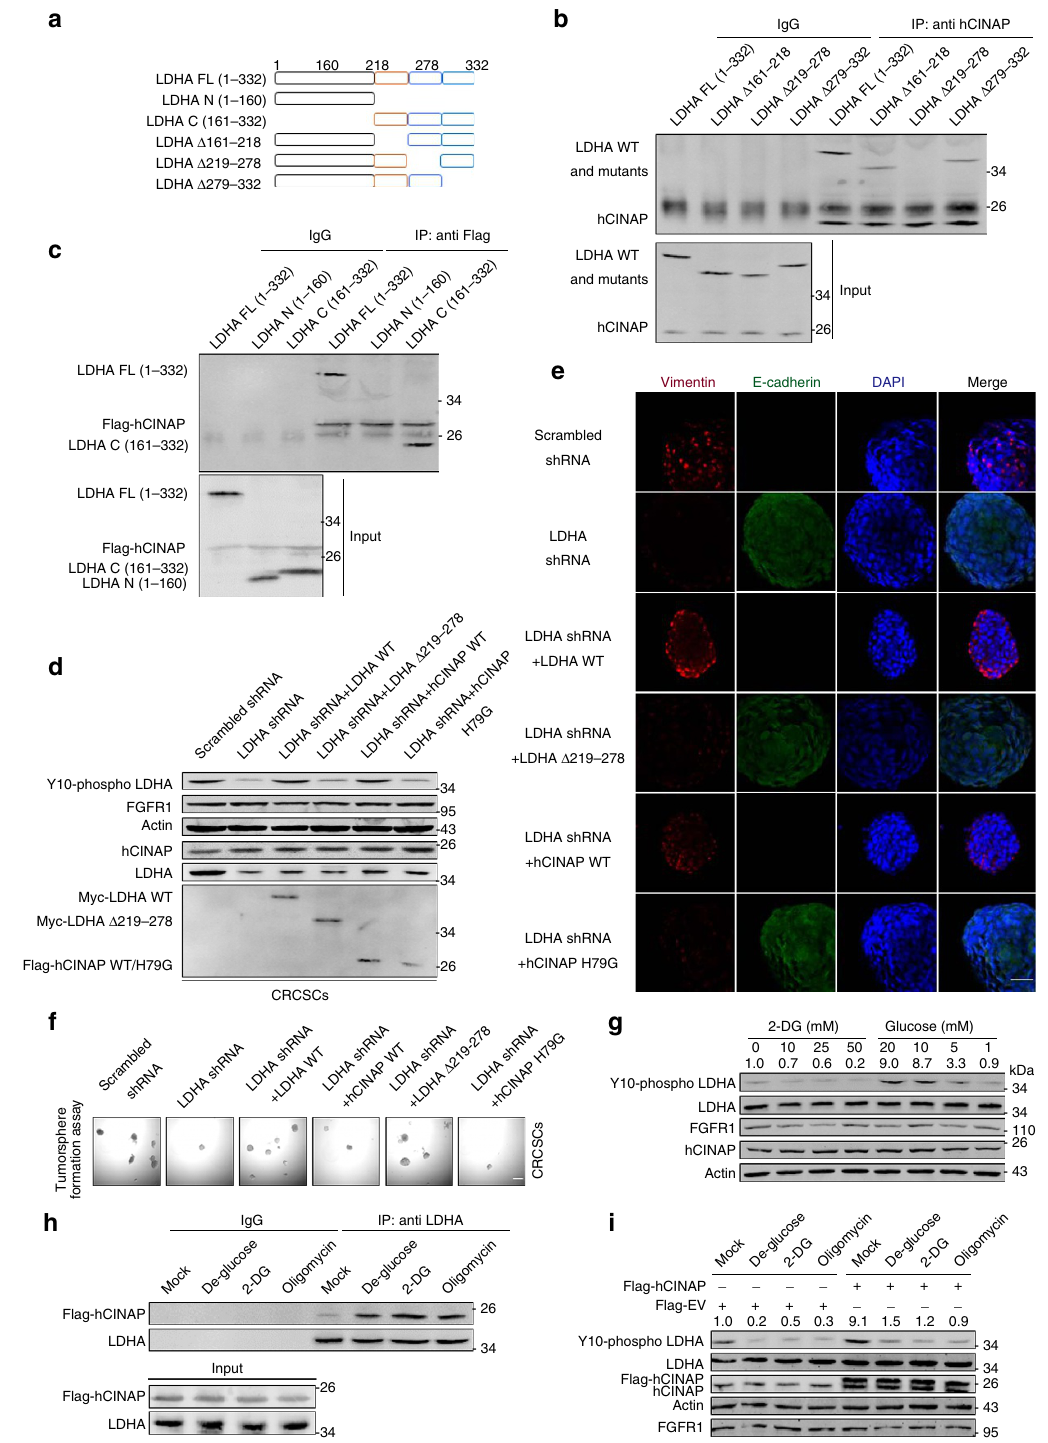
Figure 5 | The C-terminal domain of LDHA recruits hCINAP to facilitate LDHAY10 phosphorylation in a low-energy state. ( a ) Schematic diagram of the structural domain organization within LDHA. ( b , c ) Co-IP analyses of the interaction between various regions of LDHA and hCINAP in SW480 cells. IgG served as the negative control. ( d ) Western blot analysis of LDHA Y10 phosphorylation level in CRCSCs transfected with indicated plasmids. ( e ) Immunofluorescence analysis of the effect of shRNA-depleted LDHA and LDHA/hCINAP rescue expression on the mesenchymal–epithelial transition in CRCSCs labelled by Vimentin (red), E-cadherin (green). The nucleus was counterstained with DAPI (blue). Scale bar, 100 m m. ( f ) Tumorsphere formation assay using cells in e . Scale bar, 100 m m. ( g ) Western blot analysis of LDHA Y10 phosphorylation in CRCSCs treated with different doses of 2-DG and glucose as indicated. ( h ) Co-IP assay for the interaction between endogenous hCINAP and LDHA protein in CRCSCs without glucose supply (de-glucose) or treated with 2-DG (50mM) or oligomycin (1 m M). ( i ) The effects of 2-DG, glucose deprivation and oligomycin on LDHAY10 phosphorylation in CRCSCs transfected with an empty vector or Flag-tagged